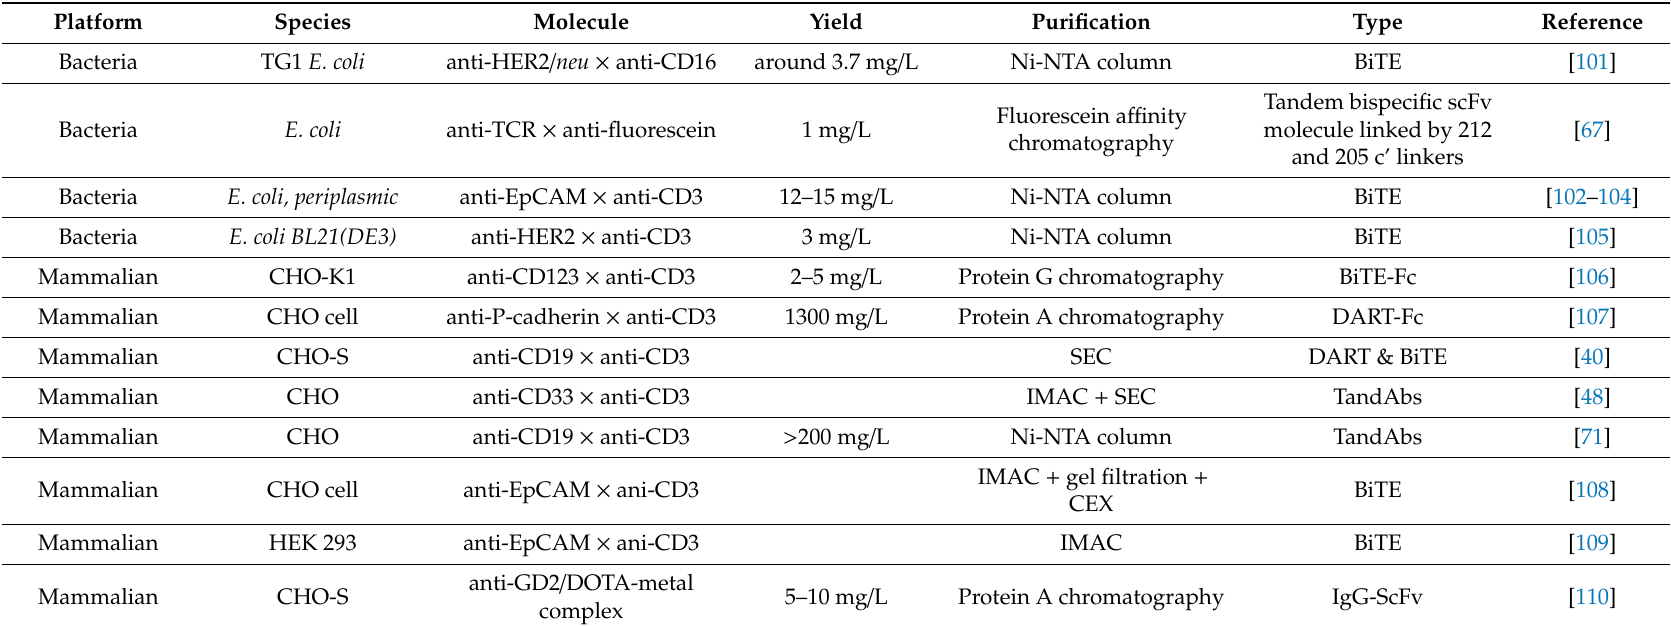
Table 1. Examples of the expression of bispecific antibody fragment molecules in various